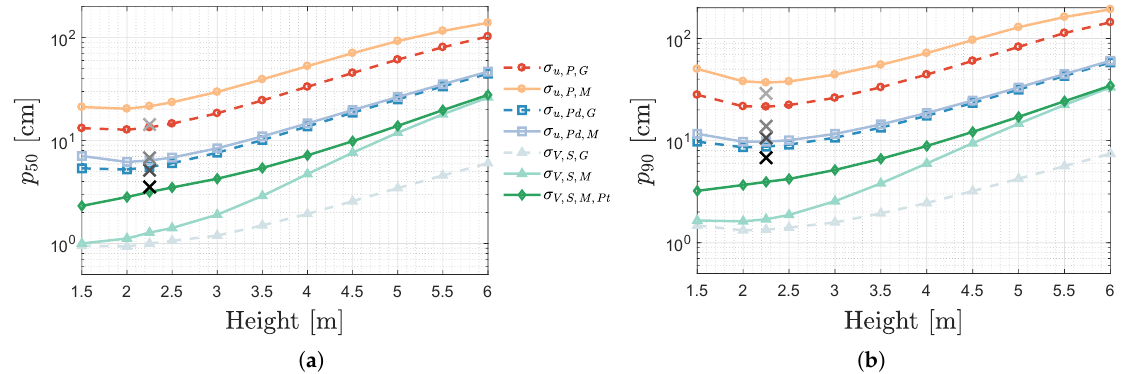
Figure 15. Influence of the perpendicular LED PD distance on (u)VLPs ( a ) p 50 and ( b ) p 90 rMSE for various noise